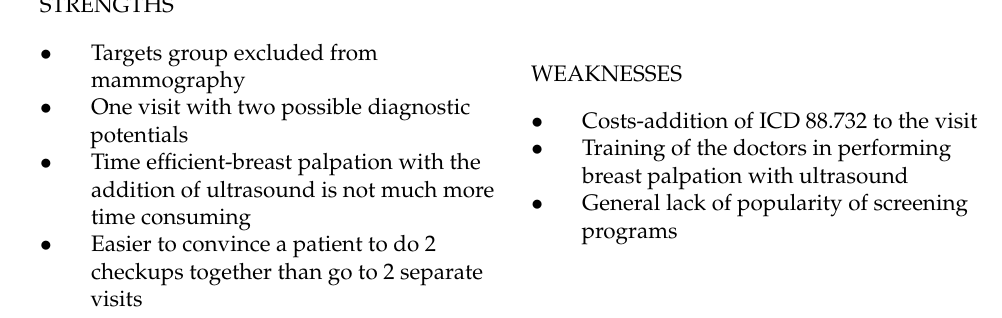
Table 1. The strengths, weaknesses, opportunities, and threats (SWOT) analysis of introducing the program.